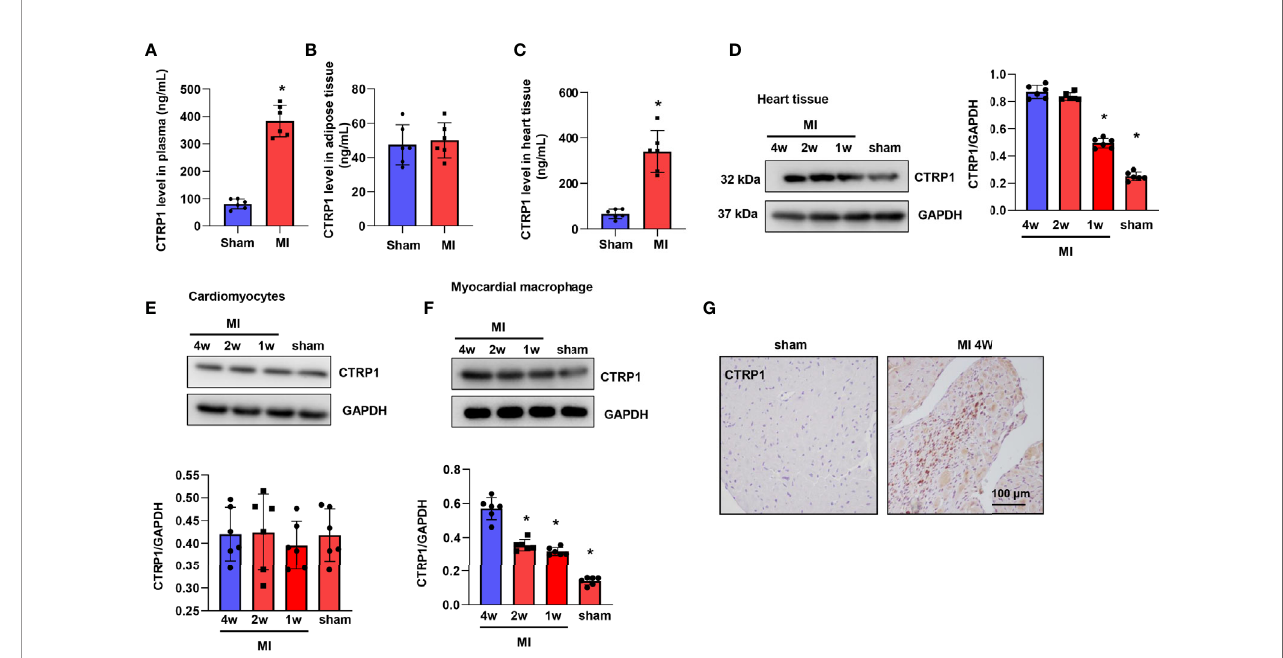
FIGURE 1 | CTRP1 expression is increased in humans and mice post MI. (A) CTRP1 protein level in mouse plasma 4 weeks after MI detected by Elisa assay (n=6). (B) CTRP1 protein level in mouse peritoneal adipose tissue 4 weeks after MI detected by Elisa assay (n=6). (C) CTRP1 protein level in mouse heart tissue 4 weeks after MI detected by Elisa assay (n=6). (D) The CTRP1 protein expression in mouse hearts post MI (n=6). (E) The CTRP1 protein expression in cardiomyocytes isolated from mouse hearts post MI (n=6). (F) The CTRP1 protein expression in macrophages isolated from mouse hearts post MI (n=6). (G) CTRP1 staining in mouse hearts post MI (n=5). * P <0.05 vs. the sham